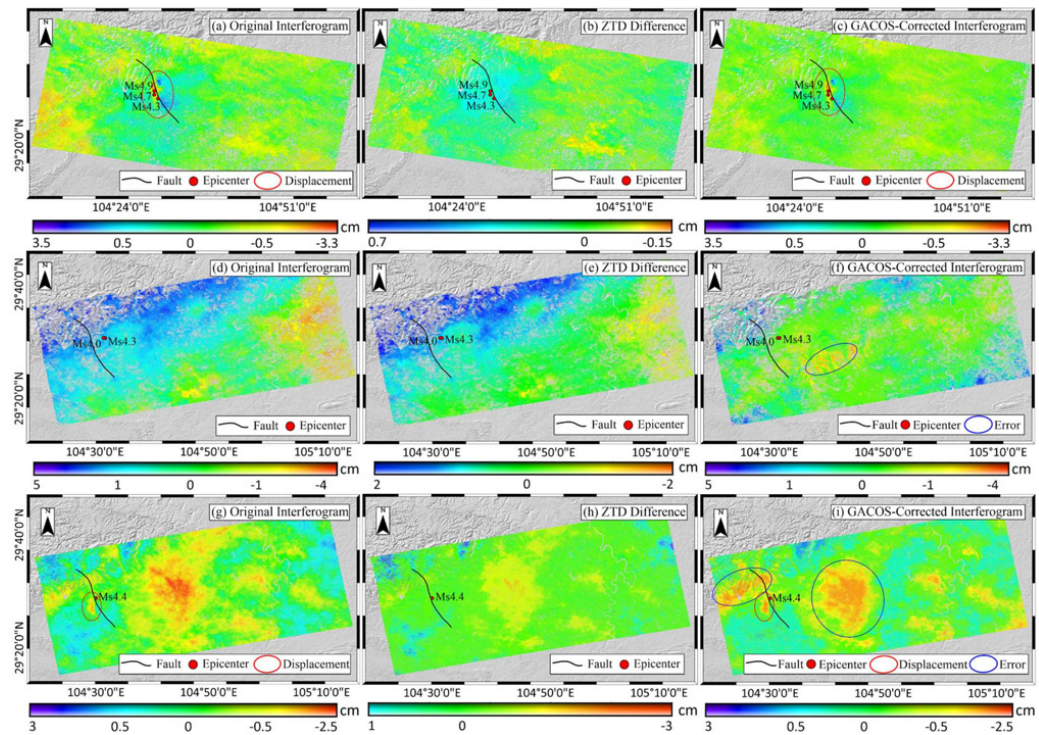
Figure 3. The original, ZTD difference and GACOS corrected images of interferograms pair ( a – c ) 20190216–20190228